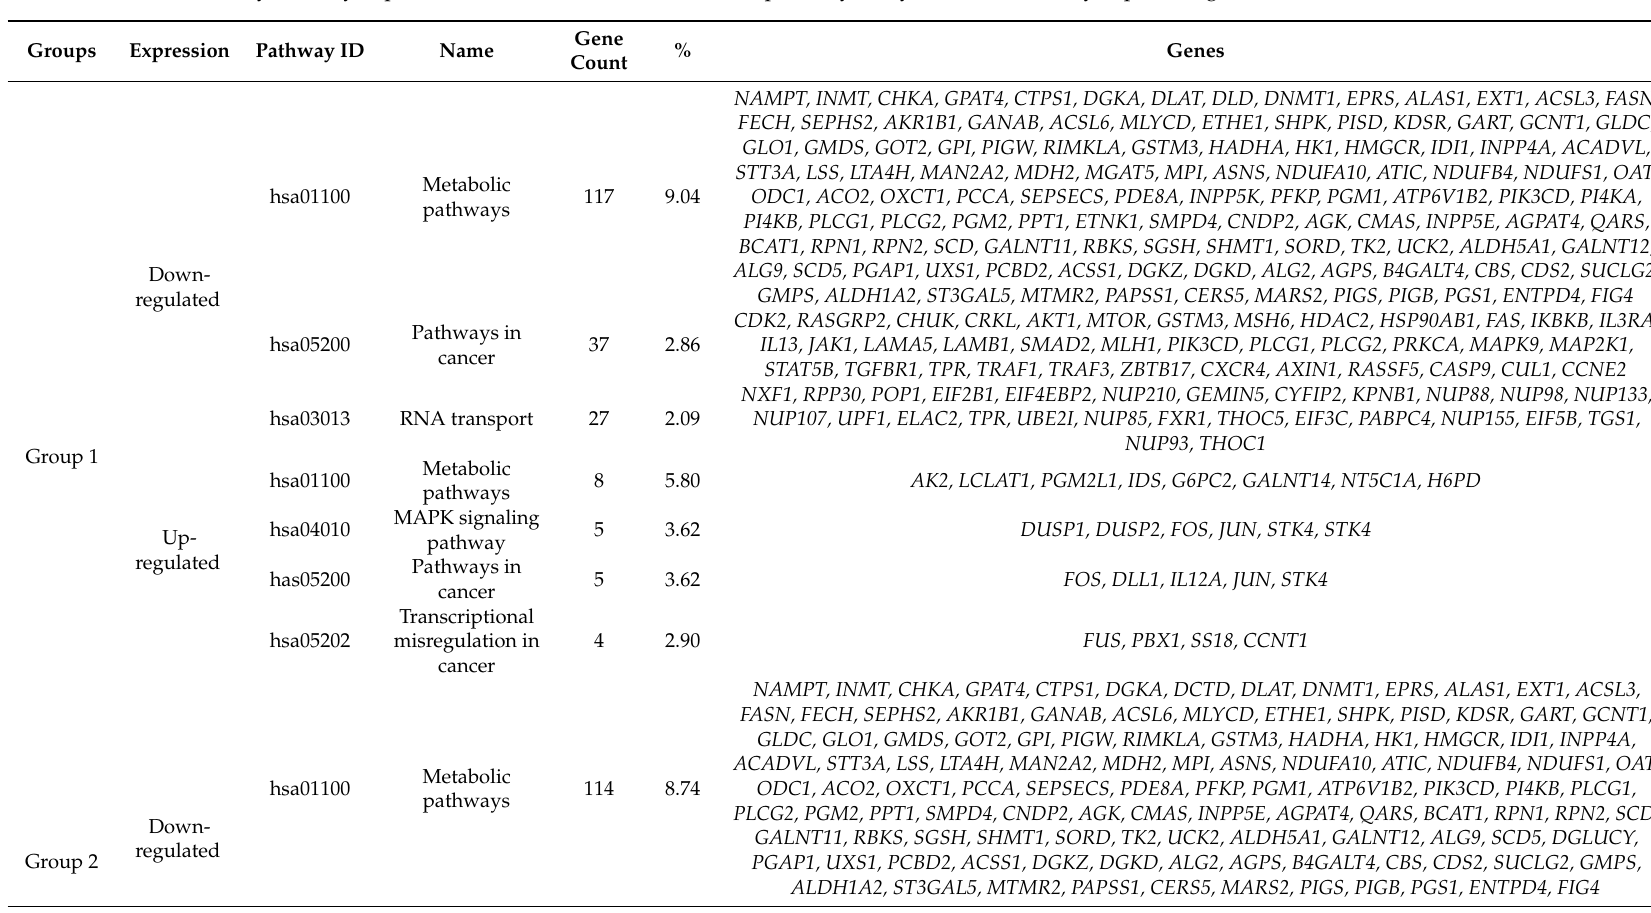
Table 2. Kyoto Encyclopedia of Genes and Genomes (KEGG) pathway analysis of di ff erentially expressed genes associated with leukemia.